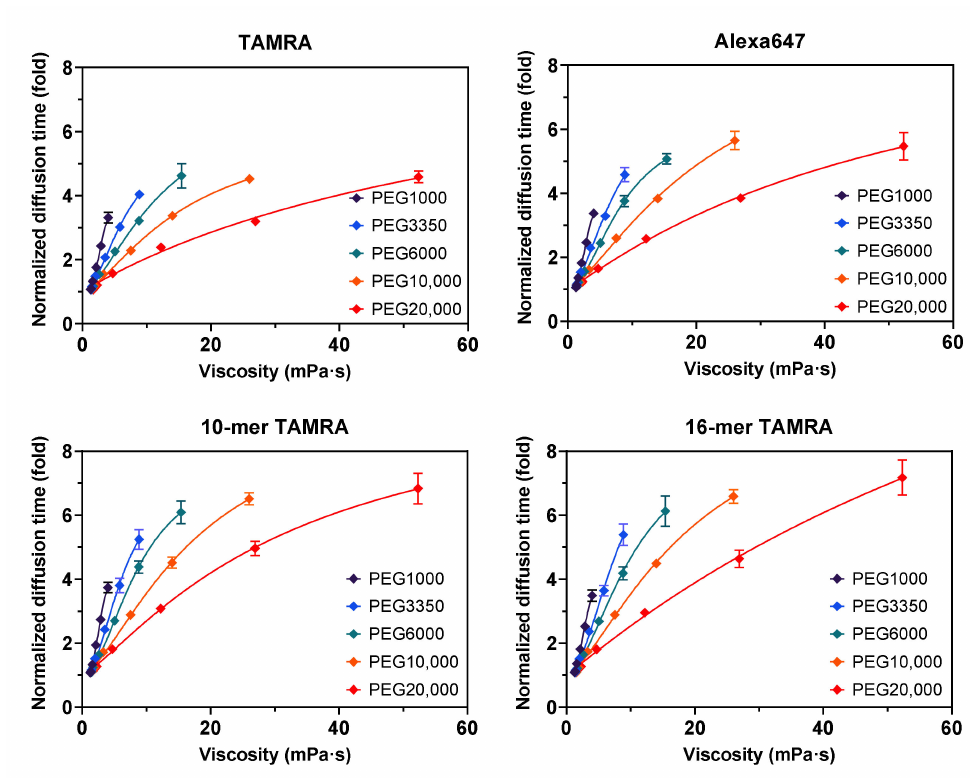
Figure 1. Measured and normalized τ D values of TAMRA, Alexa647, 10-mer TAMRA, and 16-mer TAMRA in di ff erent PEG solvents. The τ D values were measured and normalized by that measured in FCS bu ff er solution without PEG. The measurements ( n = 5) were performed in duplicate. The purple, blue, green, orange, and red points are the results in the PEG1000, PEG3350, PEG6000, PEG10,000, and PEG20,000 solutions, respectively. The data were analyzed and plotted using GraphPad Prism version 8.4.2 for Windows (GraphPad Software, San Diego, CA, USA).